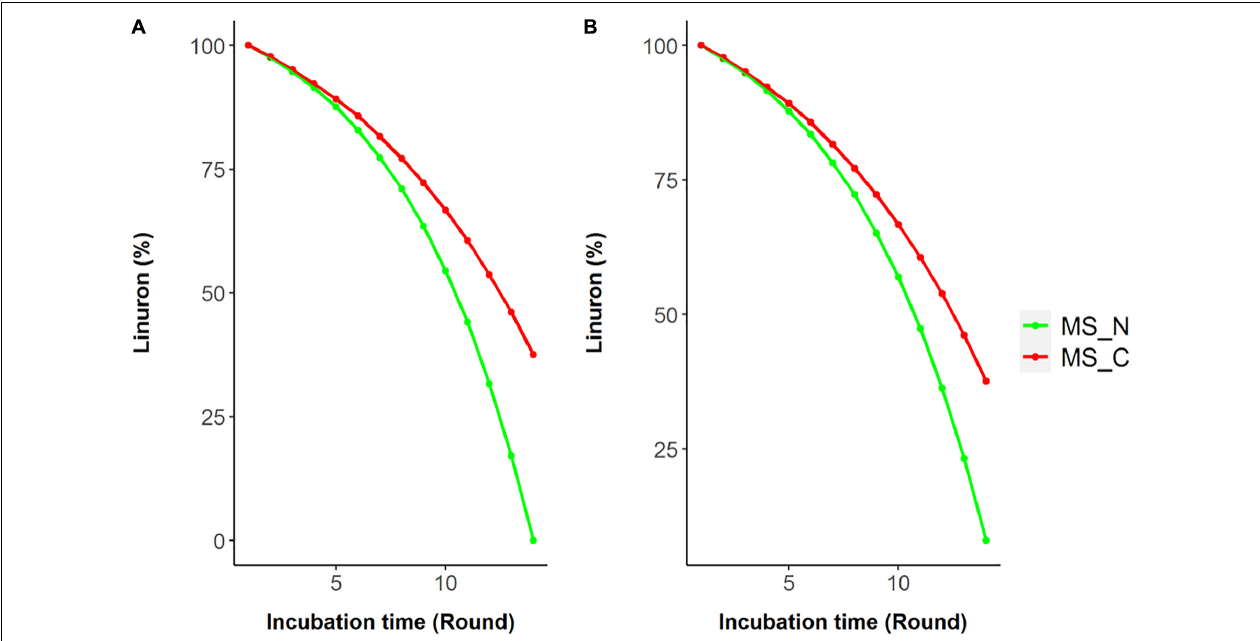
FIGURE 2 | Simulated linuron degradation in the modified media SRS 16 model considering Pathway 1 (A) and Pathways 2 and 3 (B) . Simulations were carried out in minimal mineral media (MS) with linuron supplemented by nitrogen (ammonium sulfate) or carbon (succinate) sources (MS_N and MS_C, respectively).